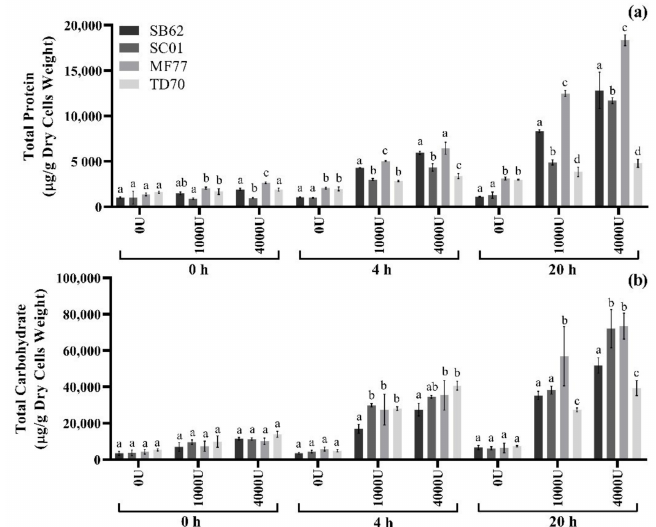
Figure 5. Total protein and carbohydrate content normalized by g dry cells weight of supernatant samples collected after enzymatic treatment (1000 and 4000 U lyticase/g dry cells weight incubated for 4 and 20 h at 37 ◦ C, with negative controls excluding enzyme and/or incubation time) of SB62, SC01, MF77 and TD70 cells collected after 4 min of ultrasound treatment (50% duty cycle and 80% amplitude). ( a ) Total protein determined by BCA protein quantification. ( b ) Total carbohydrate determined by the phenol-sulphuric acid test. The data points shown are means for triplicate experiments and the error bars indicate standard deviation between replicates. Different letters indicate significant differences ( p < 0.05) between species within each separate extraction condition as analyzed by two-way ANOVA and the Fisher’s LSD